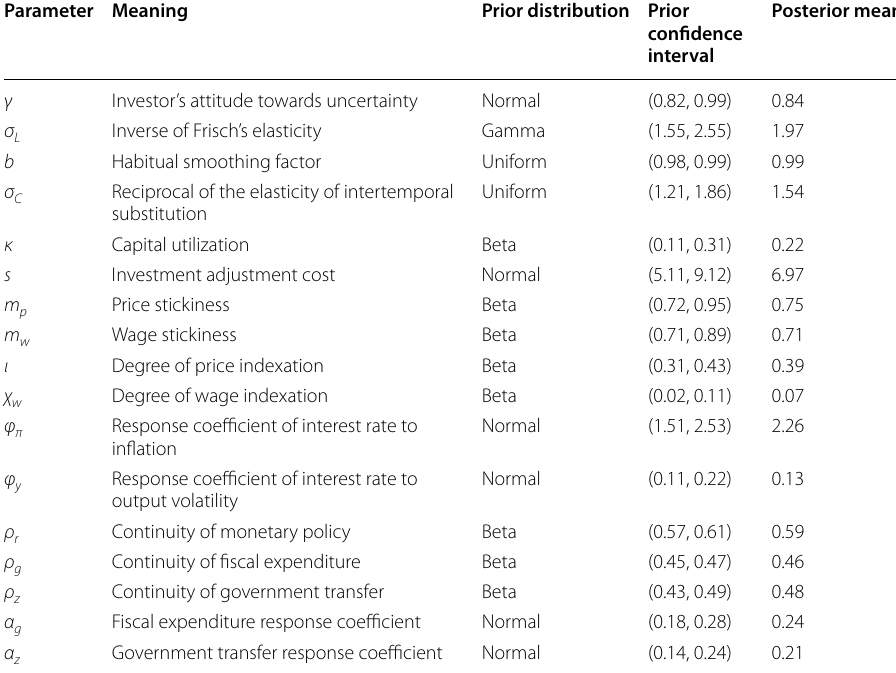
Table 1 Bayesian estimation results of structural parameters Parameter Meaning